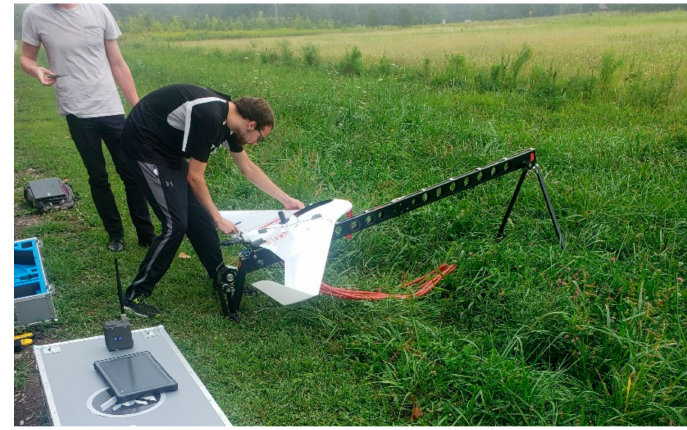
Figure 2. C-Astral Bramor Fixed-Wing Launching